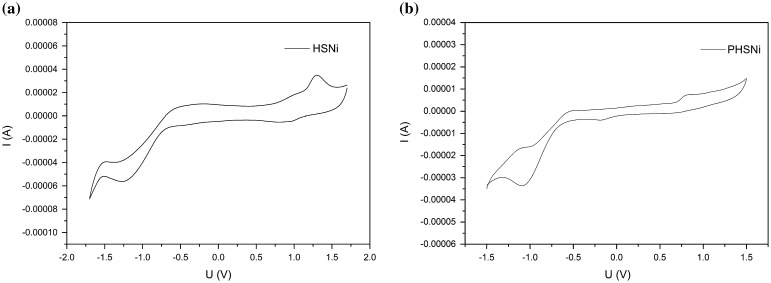
Cyclic voltammetry curves in degassed CH2Cl2 with TBAPF6 as supporting electrolyte, scan rate = 100 mV/s: (a) HSNi, (b) PHSNi.